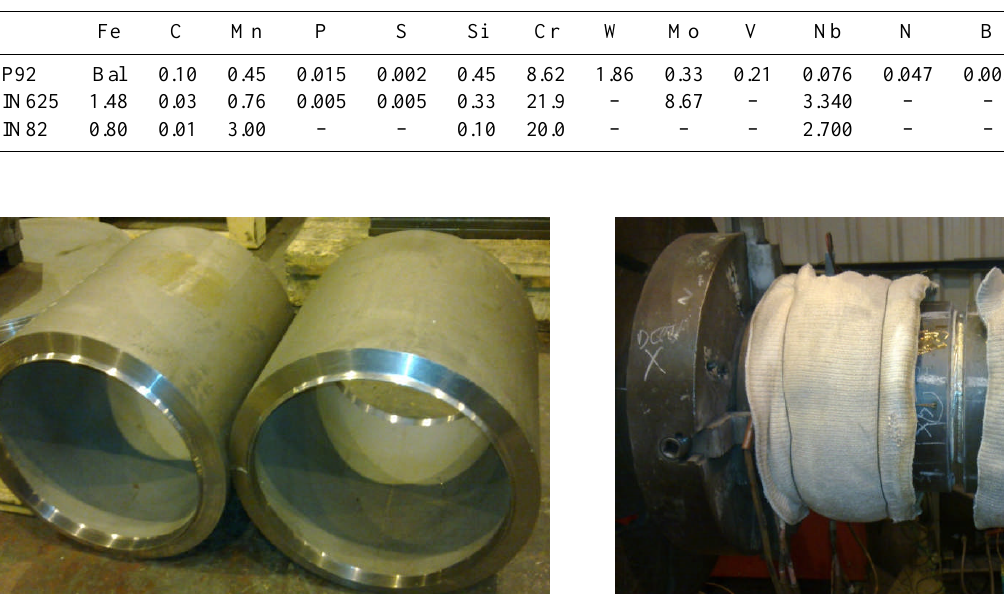
Table 1. Chemical composition of the pipe and weld materials.